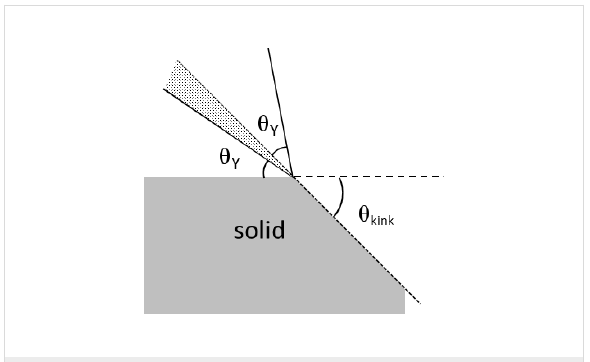
Figure 2: Surface structure induced contact line pinning in 1D: pinning occurs when θ Y < θ kink (dotted area). The two θ Y indicate the contact angle on the surface before and after the droplet has reached the